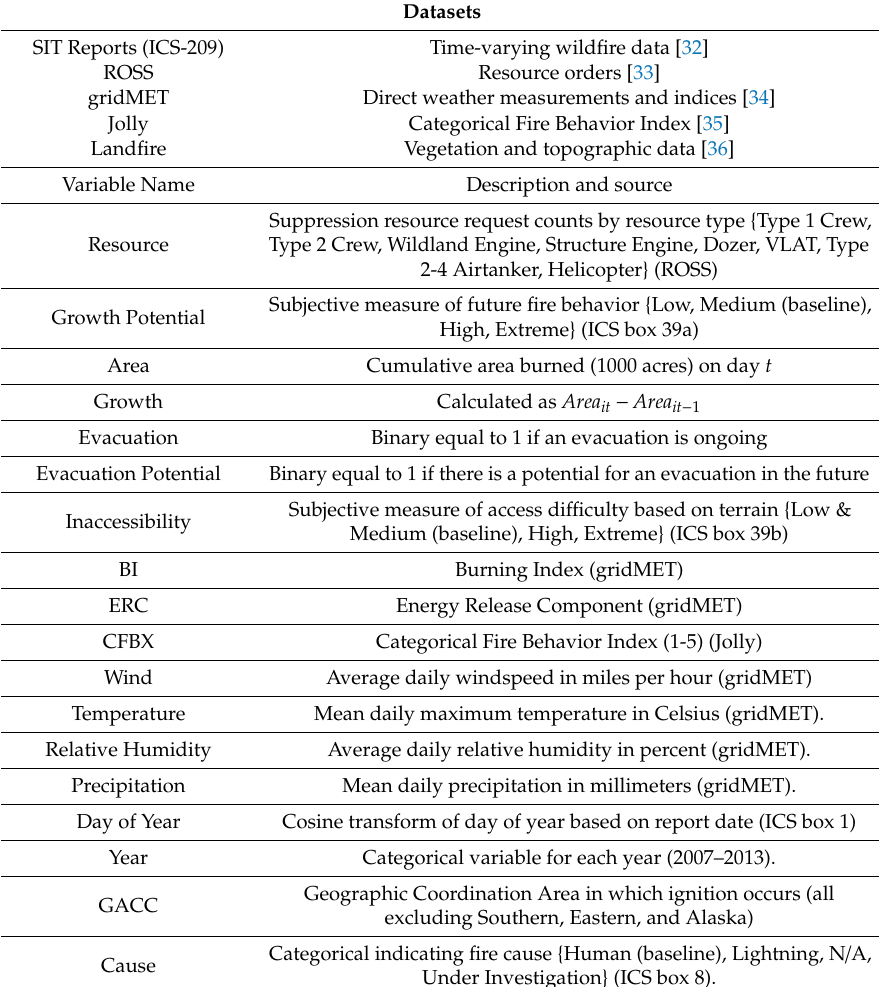
Table 2. Variable descriptions and source information of the compiled